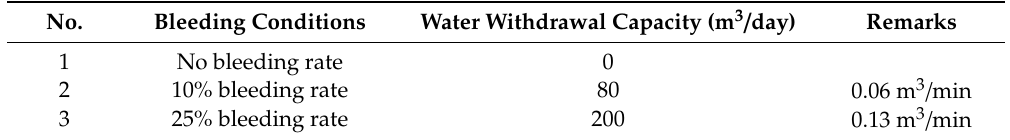
Table 2. Experimental conditions of bleeding rate for SCW